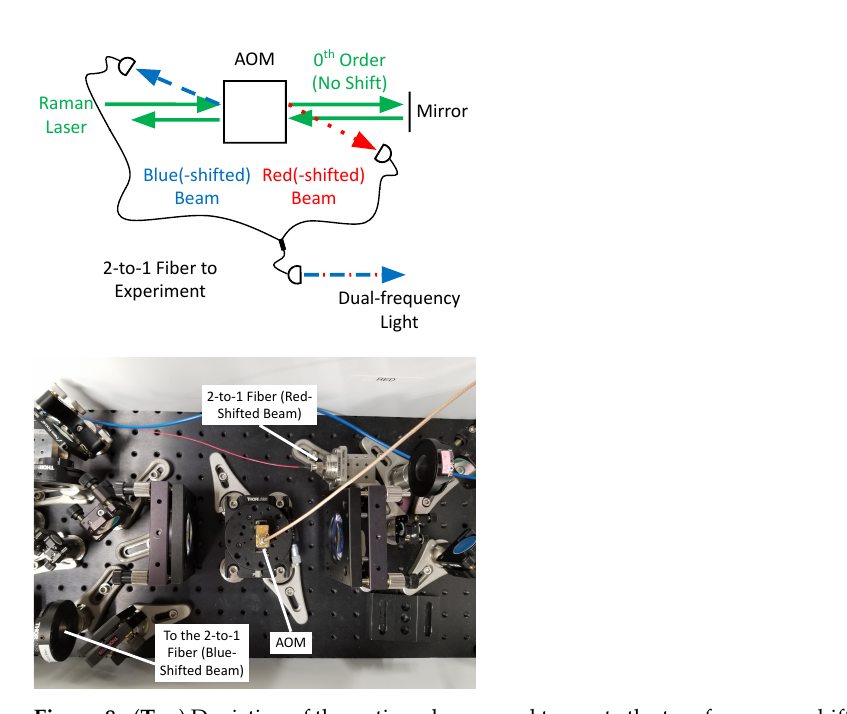
Figure 8. ( Top ) Depiction of the optics scheme used to create the two frequency-shifted Raman beams from a single laser. When the light from the Raman laser passes through the AOM, the 1st-order beam (red dotted arrow) is red-shifted by 1517.866 MHz. After retroreflection of the unshifted 0th-order beam, the 1st-order beam from the second pass (blue dashed arrow) is blue-shifted by 1517.866 MHz. These two beams are then combined via a 2-to-1 PM fiber and taken to the experiment (dashed and dotted beam at bottom of the diagram). ( Bottom ) Photo of the optics scheme used to create the two frequency-shifted Raman beams from a single